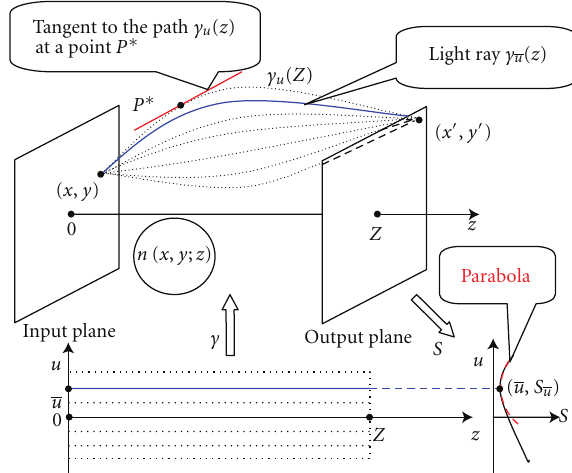
Figure 1: Illustration of the path integral applied to a layer of an inhomogeneous medium. The path integral contains three elements. (1) A collection of virtual paths connecting an input point ( x , y ) with an output point ( x (cid:2) , y (cid:2) ) can be labelled with a parameter u : γ : ( z , u ) → ( x , y ; z ) ∈ R 3 , that is, γ u (0) = ( x , y ;0) = ( x , y ) and γ u ( Z ) = ( x , y ; Z ) = ( x (cid:2) , y (cid:2) ). (2) All virtual paths going through the optical inhomogeneous medium n ( x , y , z ) from the input point ( x , y ) to the output point ( x (cid:2) , y (cid:2) ) have the optical length (cid:7) (cid:11) (cid:11) ∞ (cid:2) , y (cid:2) )] du is the optical propagator. · exp[ ik 1 + ˙ x 2 + ˙ y 2 dz . (3) The path integral K S ( x , y ; x (cid:2) , y (cid:2) ) = S : u → n ( x , y , z ) o S u ( x , y ; x −∞ A γ u The phase function S u ( x , y ; x (cid:2) , y (cid:2) ) in the neighbourhood of the stationary point u , where ∂S u /∂u | u = u = 0 can be approximated by a parabola with the vertex at point ( u , S u ). In this case the optical propagator can be approximated by the function K S ( x , y ; x (cid:2) , y (cid:2) ) = C · | K S ( x , y ; x (cid:2) , y (cid:2) ) | · exp[ ik o S u ( x , y ; x (cid:2) , y (cid:2) )], where S u ( x (cid:2) , y (cid:2) ; x , y ) is a point eikonal, that is, the optical length of the path which satisfies Fermat’s principle.